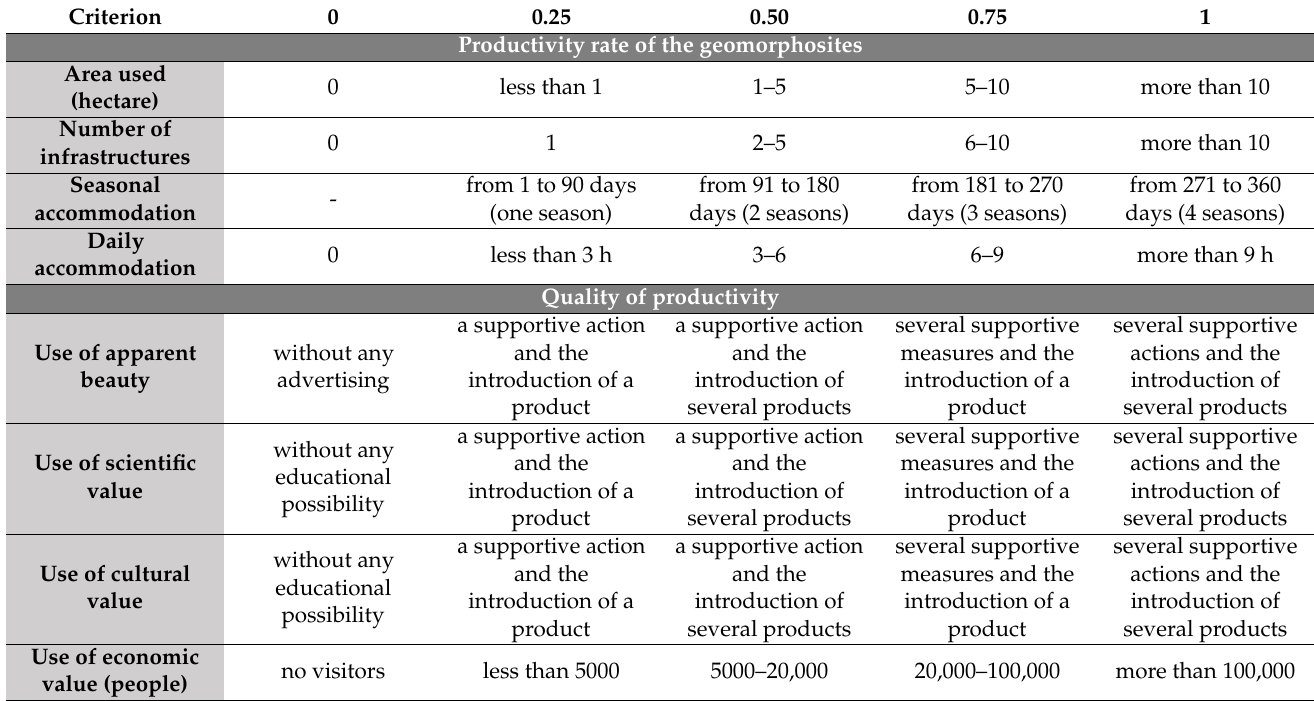
Table 5. Assessing the value of tourism productivity based on the Pralong